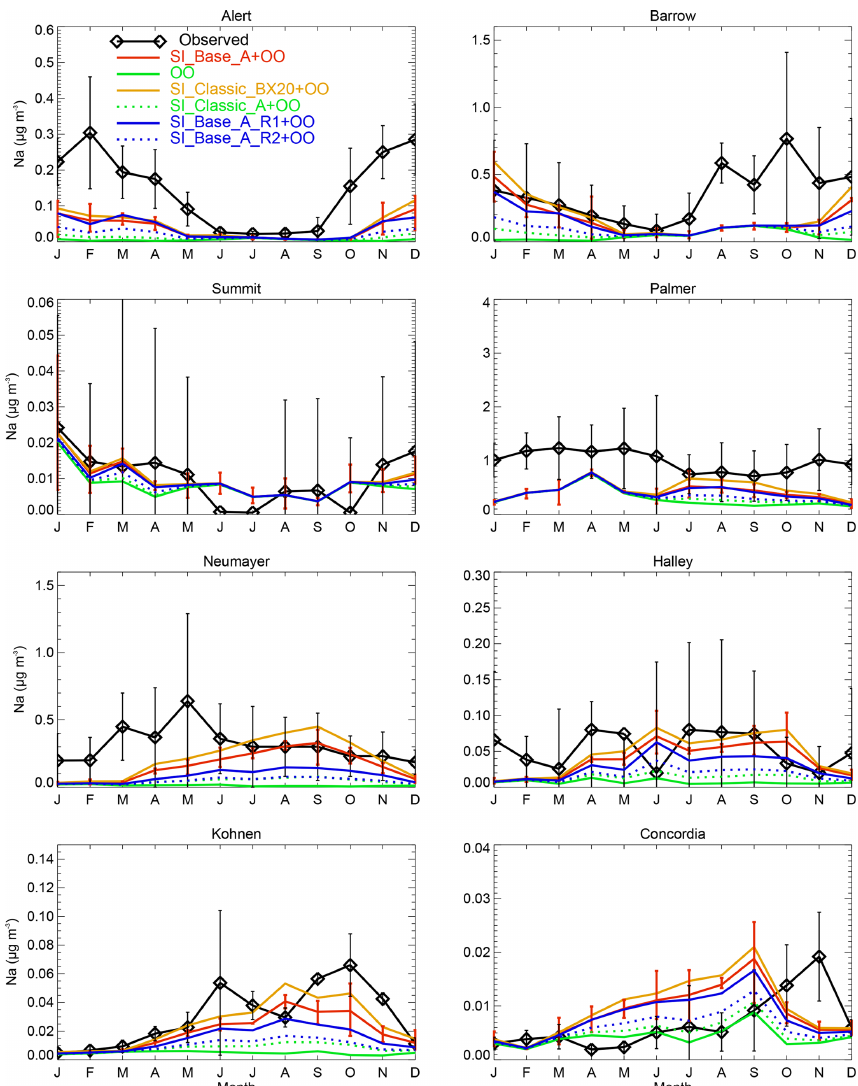
Figure 6. Monthly mean Na mass concentration at eight polar sites. Observations are shown in black with diamond symbols, with the uncertainty bars representing ± 1 σ of the inter-annual variability of the observation. Sea-spray-derived SSA is shown by the green line (from the open-ocean control run OO). Sea-ice-sourced SSA (together with sea spray) from SI_Base_A is shown by the red line with uncertainty bars representing the minimum and maximum of a 3-year integration (2013–2015). Monthly mean [Na] from the SI_Classic_BX20 run is shown in orange lines, the SI_Base_A_R1 run is shown in purple lines, the SI_Base_A_R2 run is shown in dashed purple lines, and the SI_Classic_A run is shown in dashed green lines. The mass concentration for model NaCl is at a diameter of 0.02–10µm. The aerosol data are from the following sources: the Alert, Barrow and Palmer data are from the AEROCE-SEAREX network (Savoie et al., 2002); the Neumayer data are from Weller et al. (2011); the Halley data are from Rankin et al. (2004); the Kohnen data are from Weller and Wagenbach (2007); the Concordia data are from Legrand et al. (2016); and the Summit data are from Mosher et al. (1993) but following Rhodes et al.